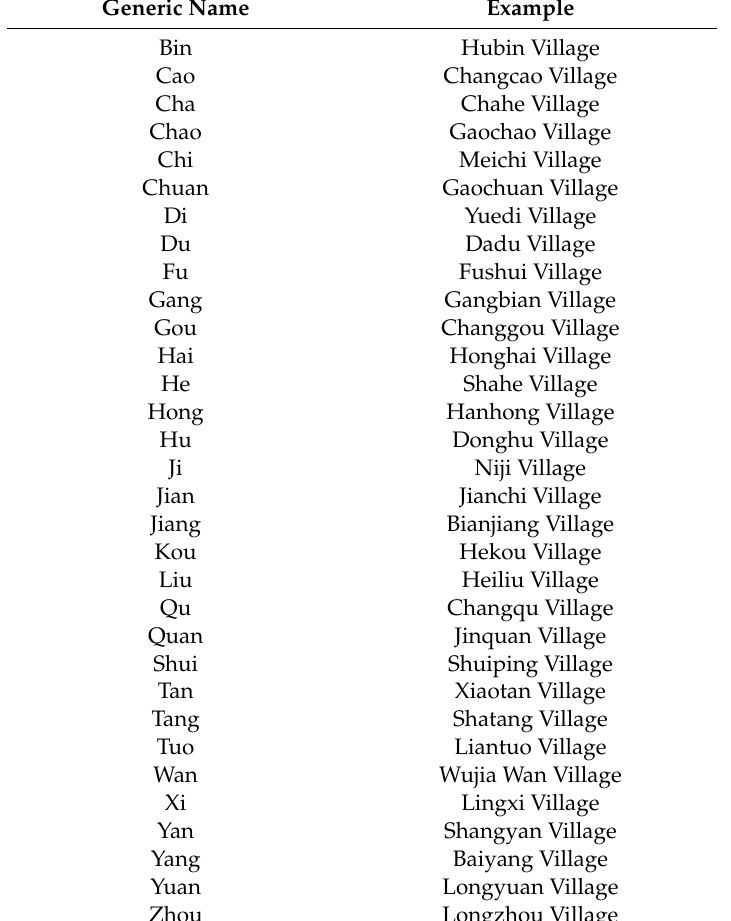
Table 1. Water-related key words in the generic names of Hubei